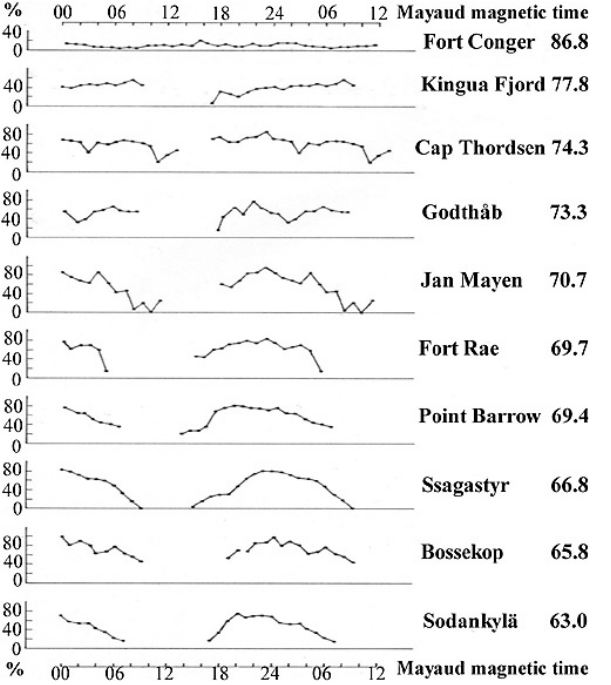
Figure 22. Daily variation in aurora occurrence frequencies 1882– 1883 (Lassen, 1963).